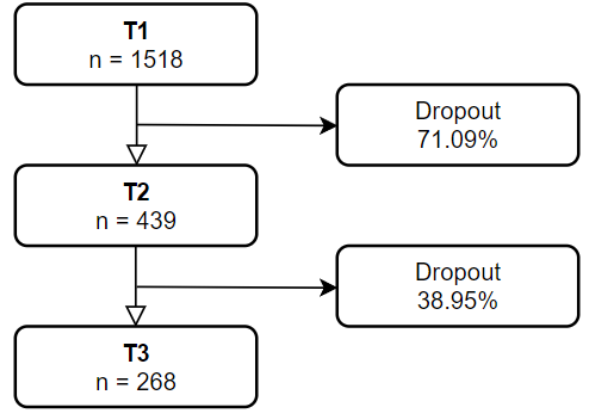
Figure 1. Flowchart of the participants’ attrition.